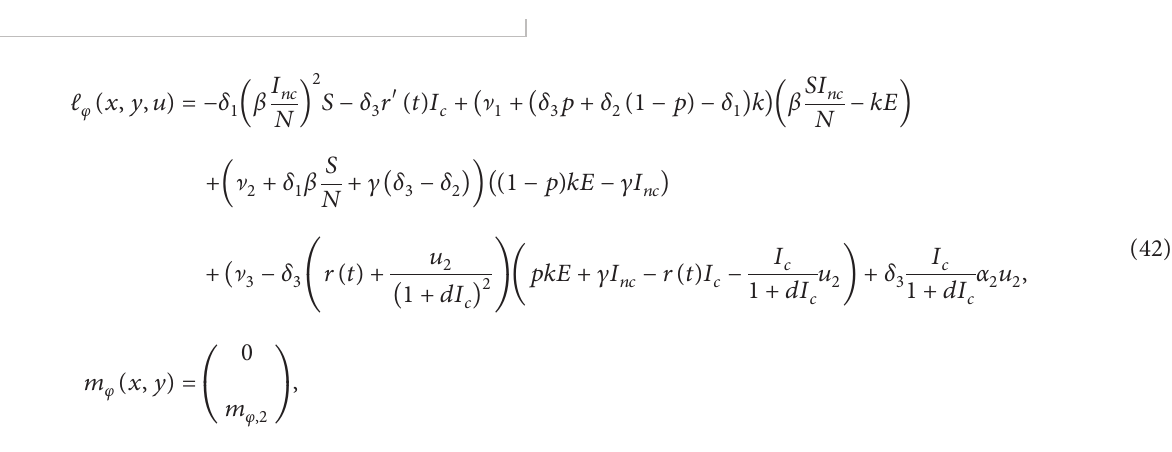
with δ � ] � ( 0 . 02 , 0 . 2 , 0 . 1 ) , α 1